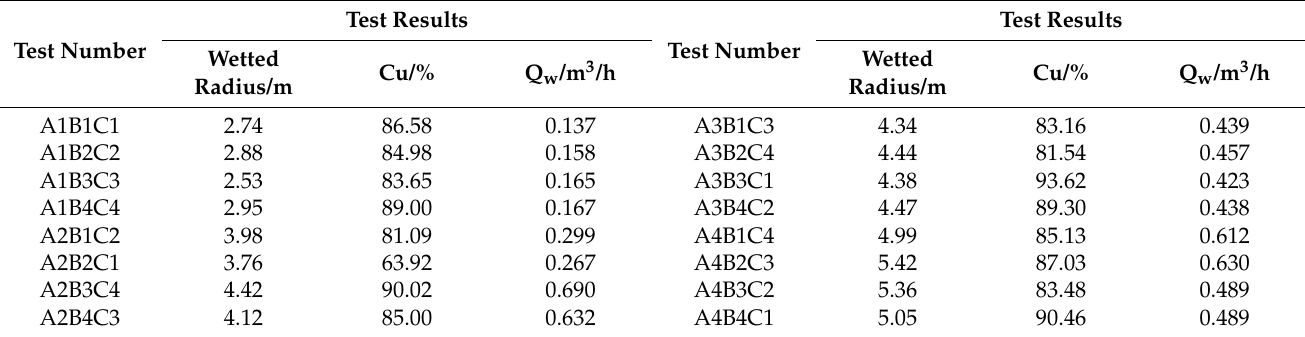
Table 5. Results of the tests for the performance of irrigation water.